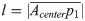
Heuristic for calculating location of unhidden neighbors.Each first (nodes B1 and B2) and second (node C) degree neighbor of node of interest (node A) contribute a score of +3 and +1, respectively, to the quadrant that they are in. Total score of each quadrant is circled. The quadrant with the least total score (quadrant I in this example) is chosen to place unhidden neighbors of the node of interest. The neighbors are placed to be “roughly” ideal edge length (l=|Acenterp1¯|) away from the node of interest.